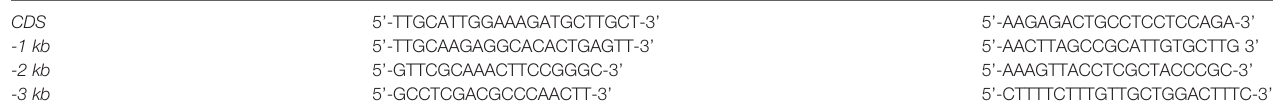
TABLE 5 | Primers for